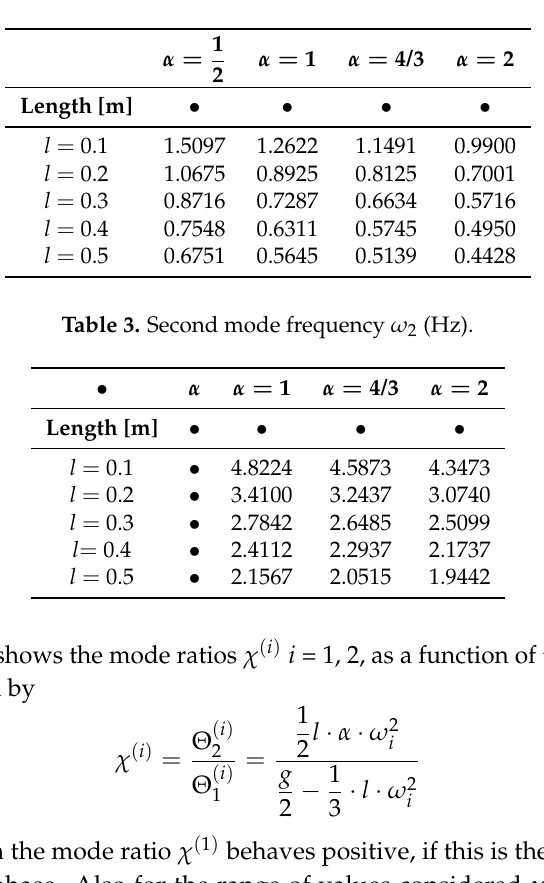
Table 2. First Mode frequency ω 1 (Hz).